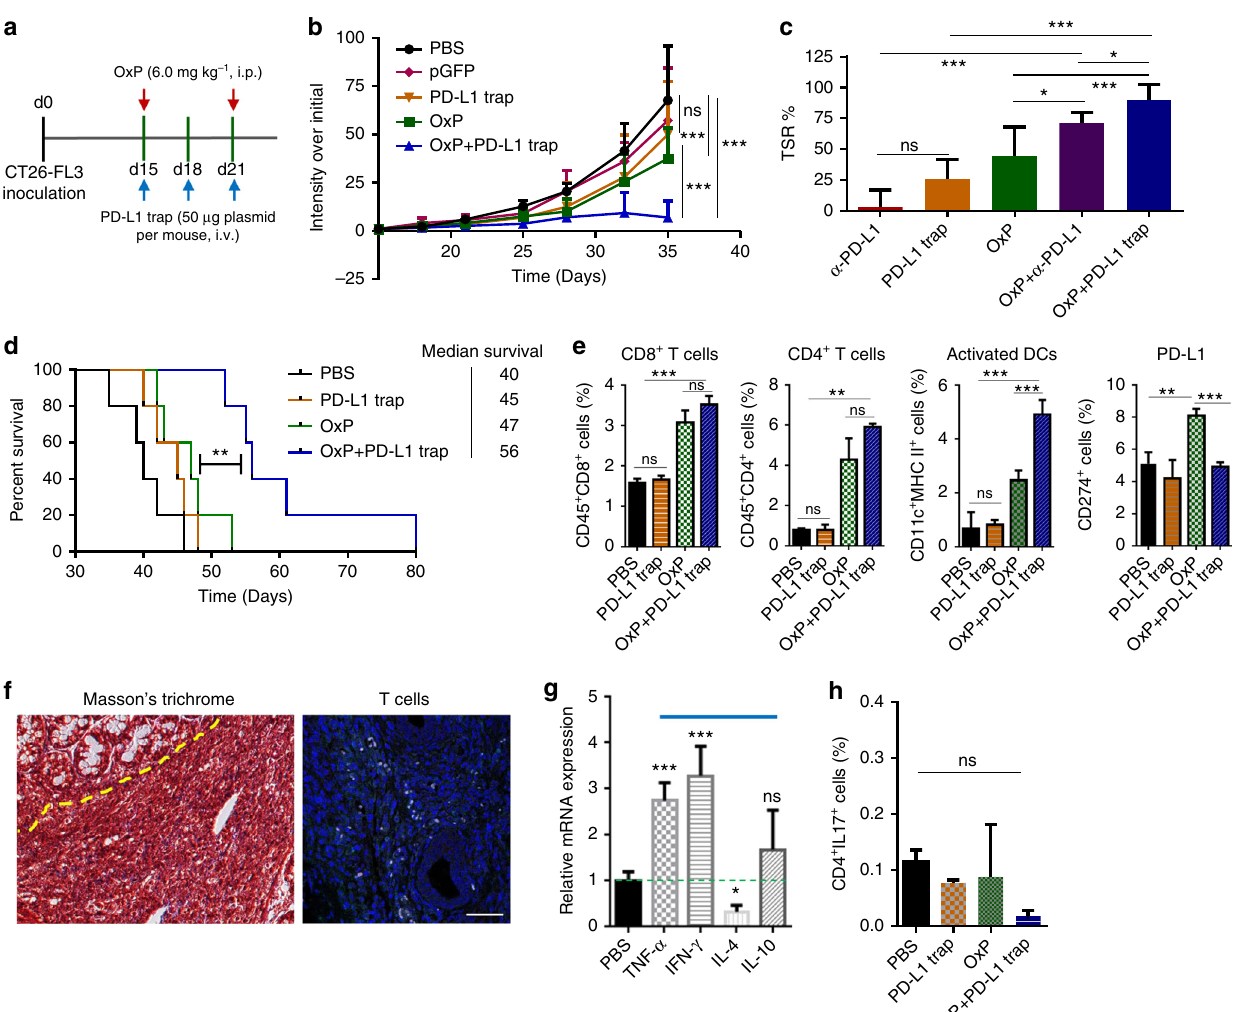
Fig. 5 Combination of OxP and LPD-PD-L1 trap gene therapy on orthotopic CT26-FL3 tumor model. a OxP and PD-L1 trap combination treatment scheme. b Tumor growth curves of orthotopic CT26-FL3 tumors in PBS, LPD-pGFP, PD-L1 trap, OxP and OxP + PD-L1 trap gene treated groups ( n = 5 mice per group). c TSR% results on day 35. d Mice survival curves. e CD8 + T cells, CD4 + T cells, activated DCs and PD-L1 levels in tumors of mice after various treatments, analyzed by fl ow cytometry ( n = 4). f Masson ’ s trichrome and immuno fl uorescence staining of the orthotopic tumors after OxP + PD-L1 trap treatment using DAPI (blue) and anti-CD3 (red). Yellow dotted line indicates the border between intestinal mucosa and the orthotopic tumor. Scale bar represents 50 μ m. g Relative mRNA expressions of cytokines in tumors of the OxP + PD-L1 trap treated group compared to PBS group on day 28, detected by quantitative RT-PCR ( n = 4). h Th17 cell ratios in the splenocytes of mice after various treatments on day 28 ( n = 4). Signi fi cant differences were assessed in b using two-way ANOVA with multiple comparisons, in d using log rank test and in c , e , g , and h using t test. Results are presented as mean (SD). ns, not signi fi cant. * P < 0.05, ** P < 0.01, *** P <